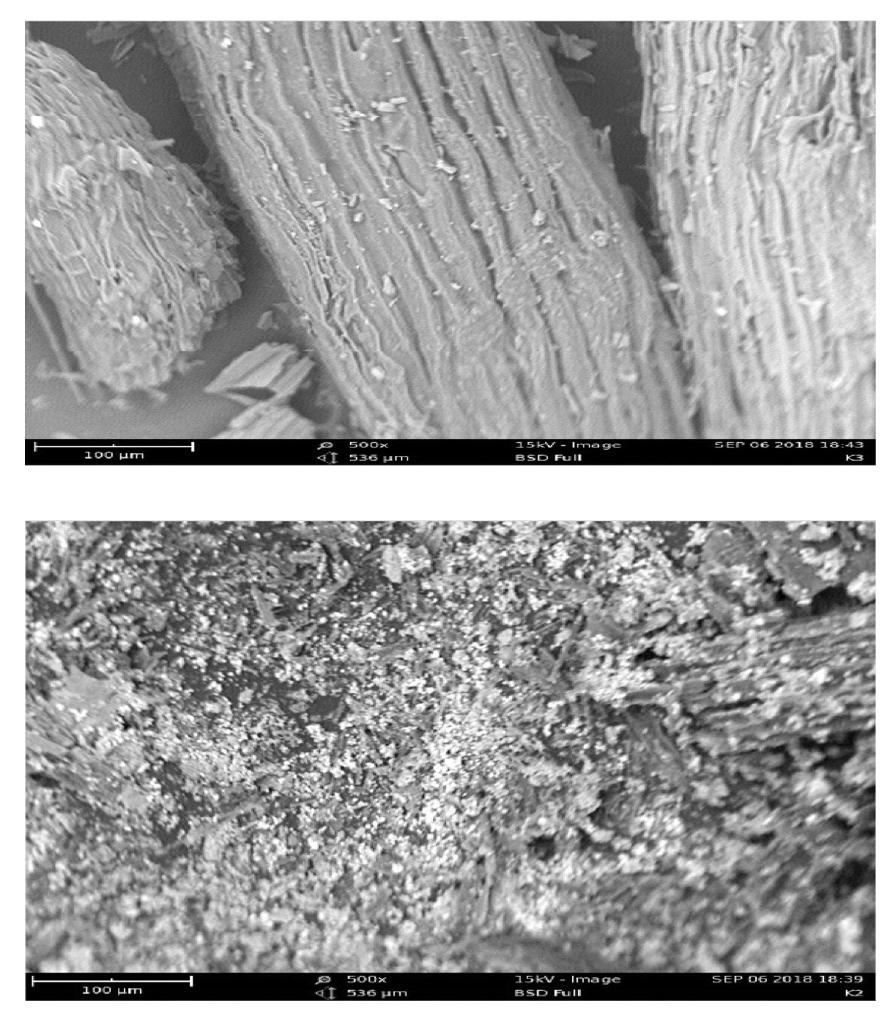
Fig. 5 SEM image of LAC before adsorption